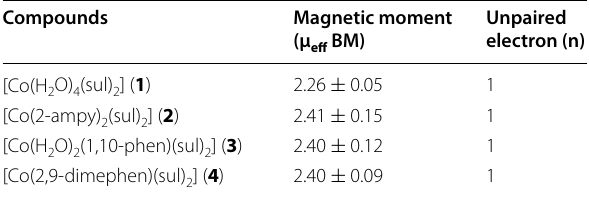
Table 2 Magnetic properties of cobalt(II) compounds